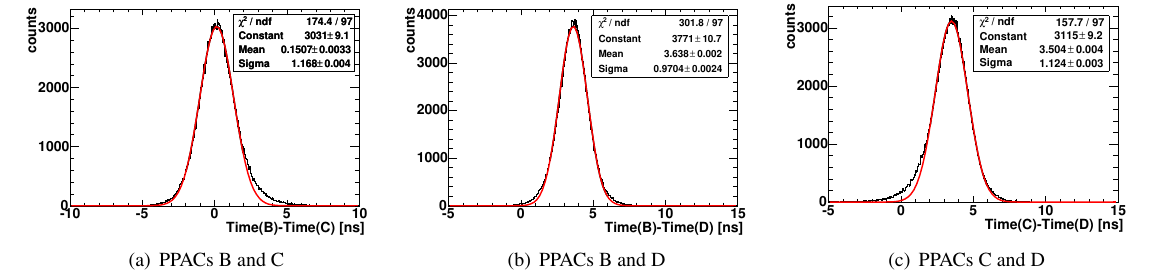
Figure 3. Measured time-di ↵ erence distributions (in black) and Gaussian fits (in red) for the case of ↵ particles from 241 Am. Each plot represents a di ↵ erent pair of PPACs.